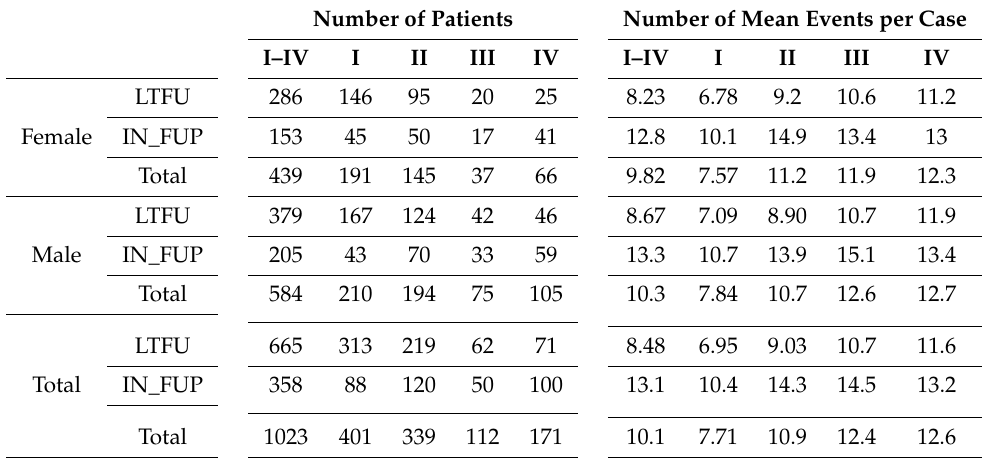
Table 1. Number of patients and mean number of events per case in log files split by maximal American Joint Committee on Cancer (AJCC) stage and separated by LTFU (lost to follow-up) and IN_FUP (in follow-up). The distribution of the outcome indicators LTFU and IN_FUP show significant differences between the AJCC